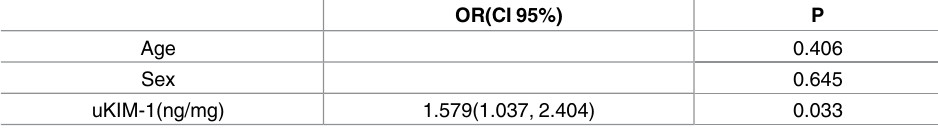
Table 4. Logistic regression shows that the uKIM-1 level is a risk factor for non transient AKI.